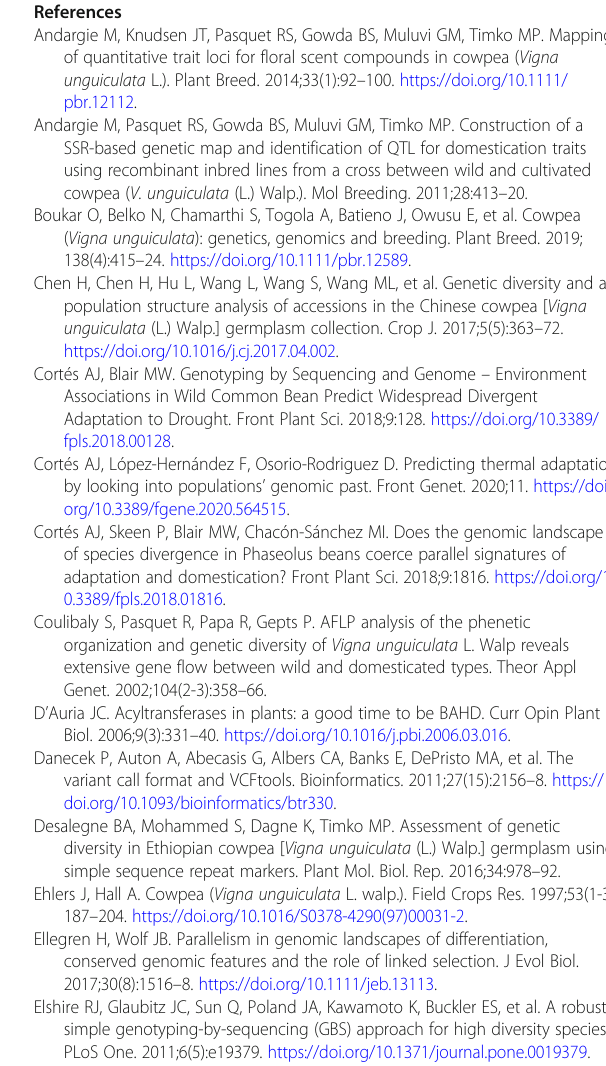
Additional file 1: Table S1. Passport data of cowpea accessions used in this study. Table S2. Genes discovered within the selective sweep regions between three cowpea subspecies. Figure S1. Distribution of genotyping by sequencing (GBS) identified single nucleotide polymorphism (SNP). Marks represent loci found on eleven chromosomes of the Vigna unguiculata (IT97K-499-35) cowpea reference genome. Scales at the margins of this figure represent sequence length in mega base- pairs. Figure S2 . Frequency distributions of relative differentiation ( F ST ) profiles among three cowpea subspecies. Average pairwise F ST values per sliding window (window size =100 kb, step size = 10kb) are shown be- tween: a) grain and fodder cowpea, b) grain and yardlong bean, and c) yardlong and grain cowpea. Dashed vertical lines mark the α = 0.001 threshold for detection of outliers based on whole-genome permutation tests. Figure S3. Genomic landscape of divergence among three cowpea subspecies. Sliding window analyses (window size =100 kb, step size = 10kb) are depicted for average relative differentiation ( F ST ) between: a) grain and fodder cowpea, b) grain and yardlong bean, and c) yardlong and grain cowpea. D, average windowed LD, as measured by R 2 , for all accessions. Dashed horizontal lines indicate overall mean and the α = 0.001 threshold (upper line, when applicable) in b) and c) for detection of outliers based on whole-genome permutation tests. Green and blue blocks indicate the outlier regions identified between each comparison. Colored dots above the outlier regions in b) and c) mark known QTLs (Table 2) for pod length (in green), flower scent (in red), and seed coat pattern (in blue). Results of all windowed analyses are plotted against window midpoints in millions of base pairs (Mb). X -axis always shows physical distance in Mb across the 11 chromosomes of cowpea while the Y -axis comparisons always indicate F st value between C (fodder types), G (grain types), and Y (yardlong vegetable types). Figure S4. Nucleotide di- versity ( π ) of three cowpea types. These divided are by a) overall